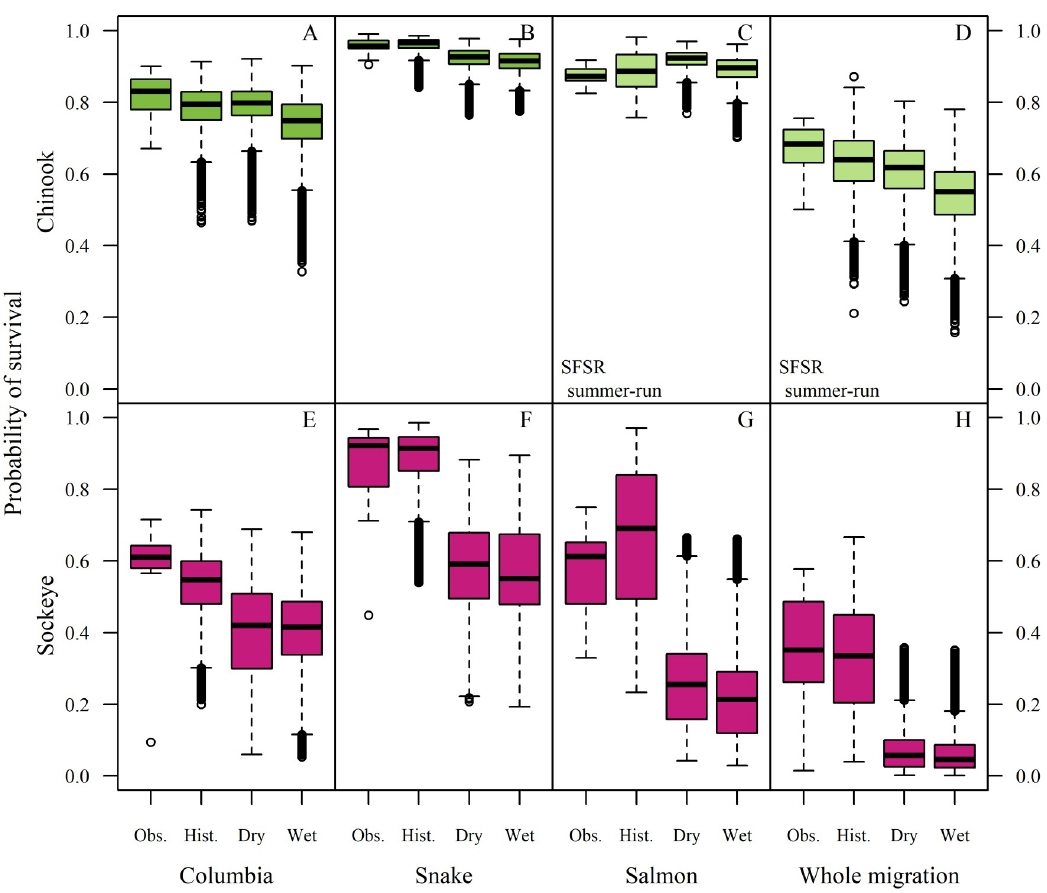
Fig 6. Boxplots of mean annual survival across reaches and climate scenarios. The first column within each panel shows the range of annual survival across years from observed tag data (line = median, box = interquartile range, whiskers = 1.5 × interquartile range). The next three columns show simulated survival across years under the historical, dry, and wet climate scenarios. The final column shows cumulative survival through the entire migration (Bonneville Dam to South Fork Salmon River for Chinook, and to the Sawtooth weir for